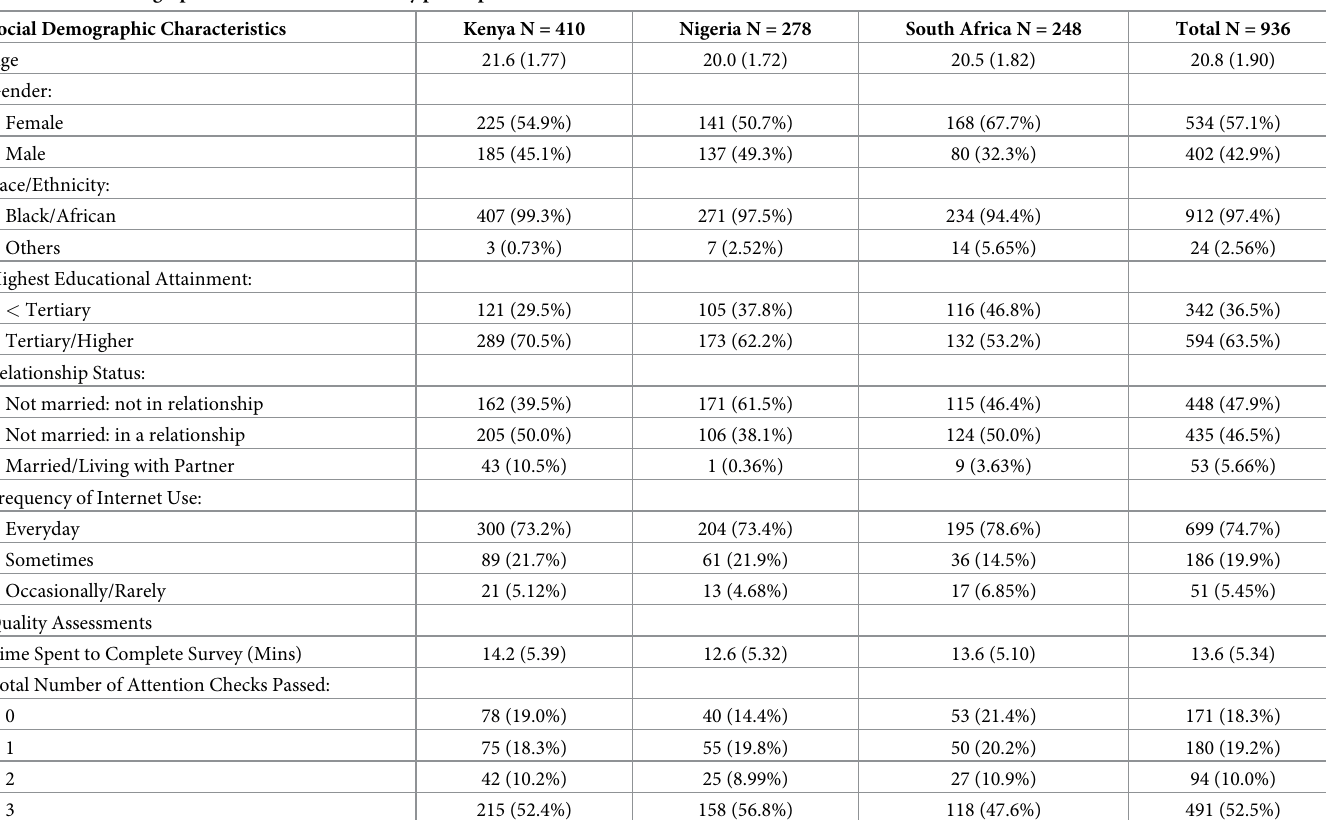
Table 4. Sociodemographic characteristics of survey participants.